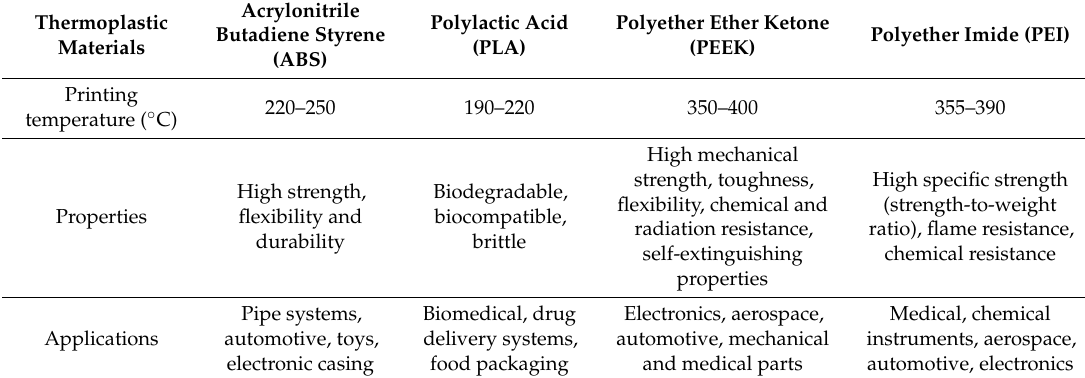
Table 2. Printing temperature, properties and applications of different thermoplastic materials used in FDM 3D